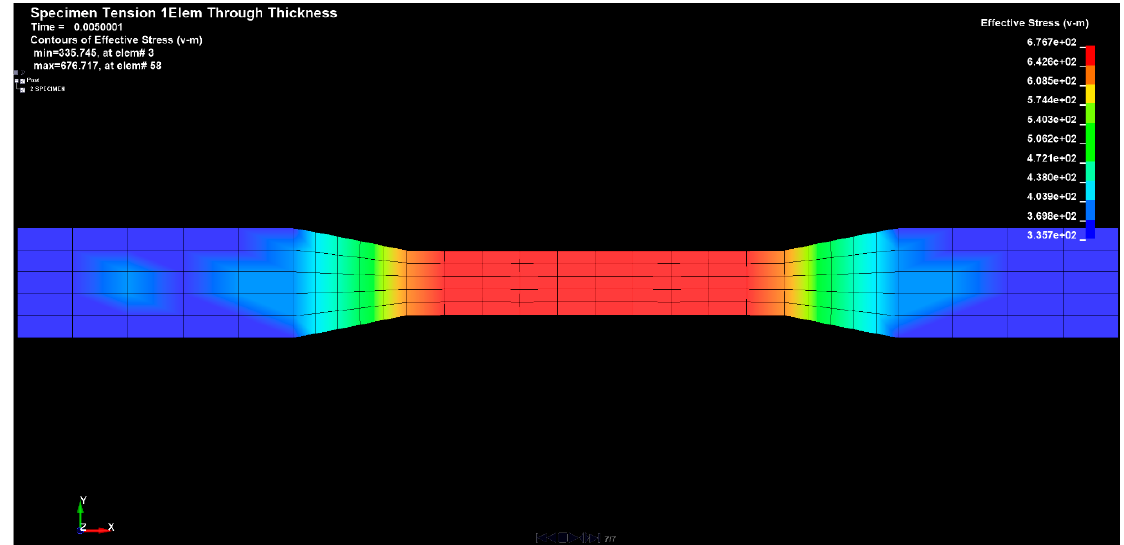
Figure 24. Sample tension in the 𝑥 direction.